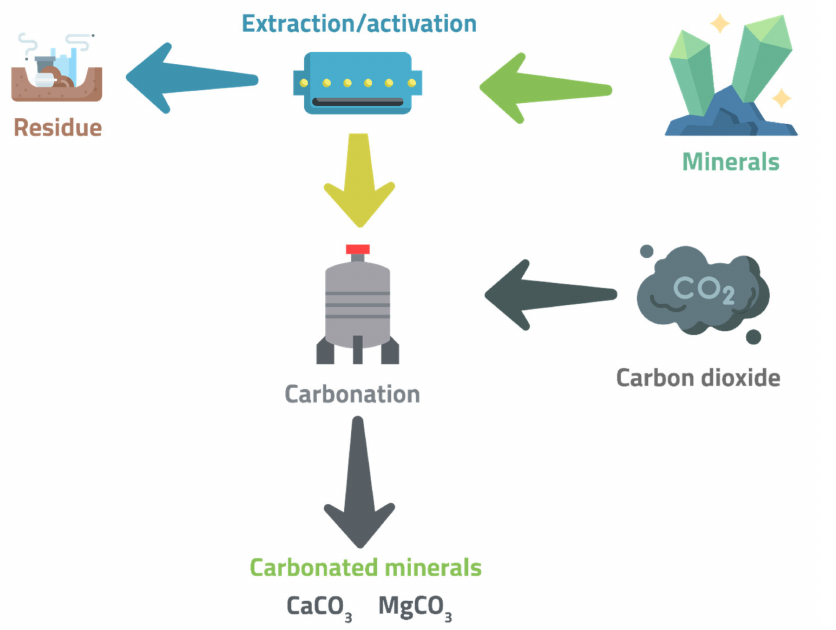
Figure 4. Principles of Indirect